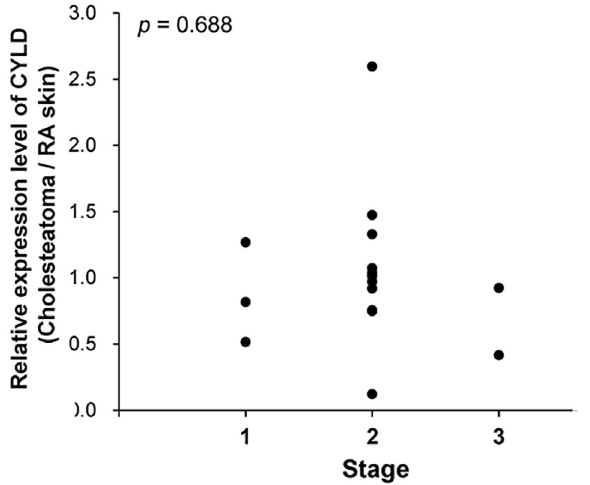
Fig 2. The relationship between the relative expression level of CYLD in cholesteatoma and the stage. Plots showing the relationship between CYLD expression in cholesteatoma and the stage. The stage was decided by JOS staging